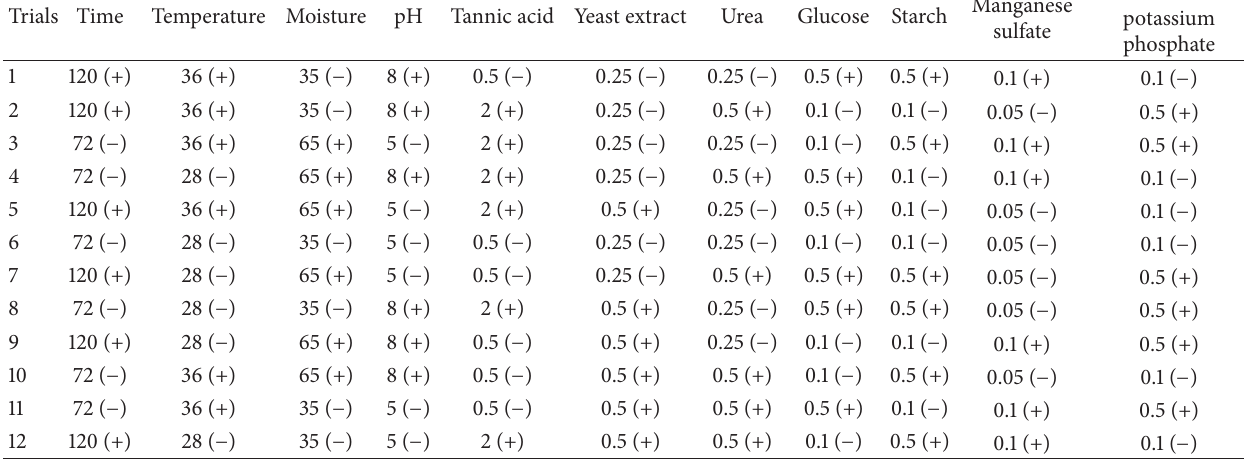
Table 3: Experimental matrix Plackett-Burman planning (PB) for the production of tannase from Penicillium montanense URM 6286 under FES using agroindustrial wastes.